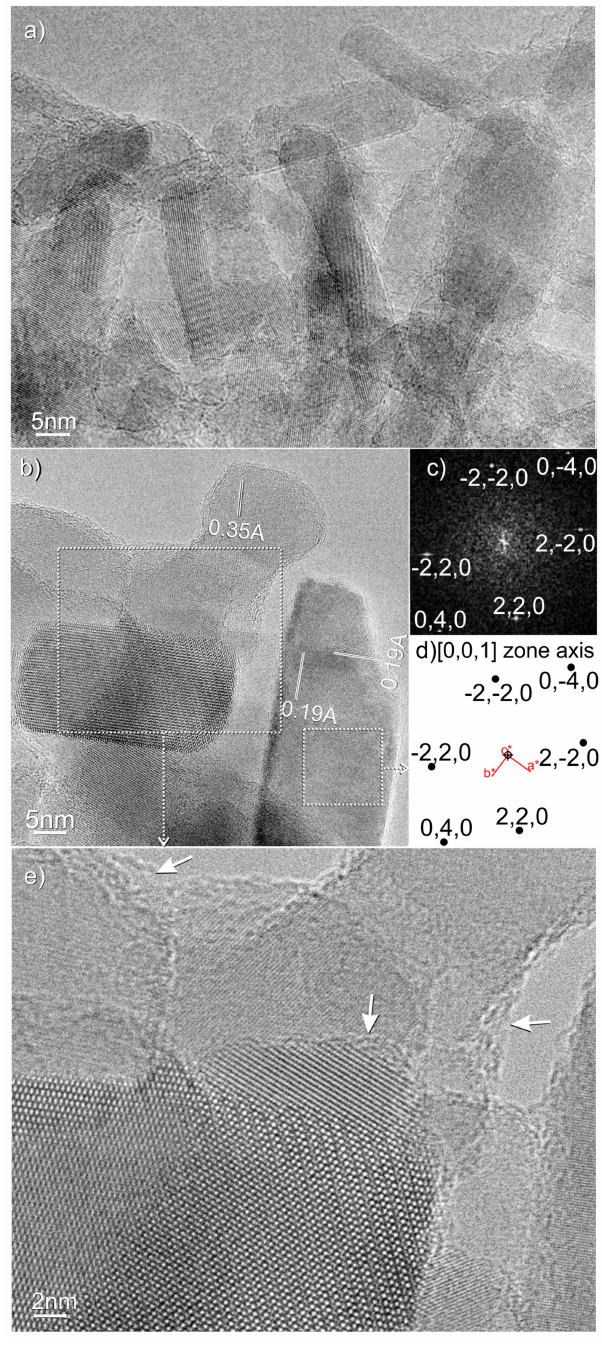
Figure 5. ( a , b ) HRTEM images of Fe-titanate nanotubes (prepared from Fe(NO 3 ) 3 0.001 M) after thermal decomposition of C 2 H 4 at 750 ◦ C for 1 (cid:48) ; ( c ) experimental FFT image of the nanoparticle selected in ( b ); which is oriented along the [001] zone axis and ( d ) the related simulated SAED pattern of the selected area in ( d ); The arrows in ( e ) highlight the carbon-decorated TiO 2 nanoparticle